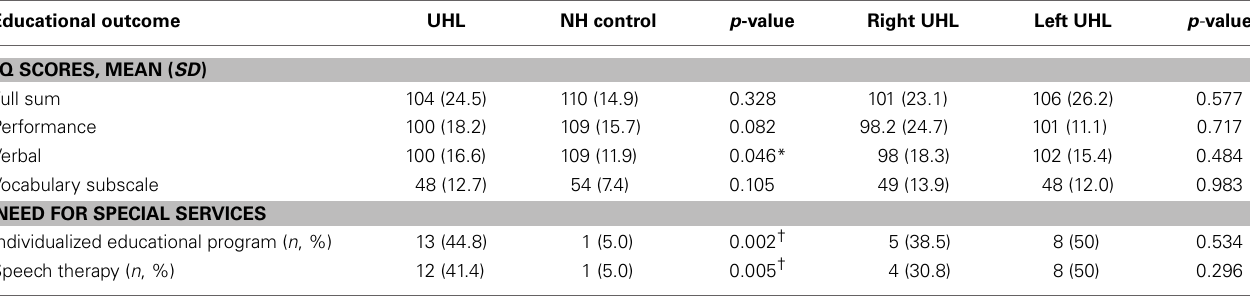
Table 3 | Comparisons between unilateral hearing loss (UHL) group and the normal hearing group (NH) for educational outcome variables, and right unilateral hearing loss (right UHL) and left unilateral hearing loss (left UHL)